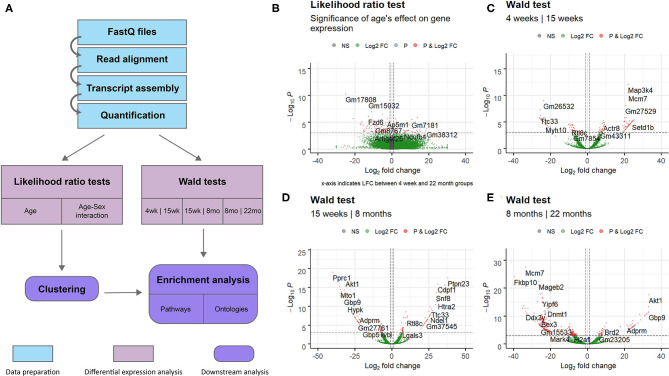
Overview of entire RNA-Seq data analysis workflow and volcano plots for dynamically expressed genes. Plots were constructed using the EnhancedVolcano (Blighe, 2019) package in R. Horizontal lines are drawn at p = 0.001. Vertical lines are added at log2 fold change values of 1 and −1. DESeq2's shrunken log2 fold change metric was used. Genes with significant differential expression (p < 0.001 and LFC >1 or LFC < −1) are colored red. (A) Flowchart of steps used to analyse RNA sequencing data obtained from mice of different age groups. Data preparation steps are colored in light blue, differential expression analysis steps are colored in pink, and downstream analysis steps are colored in purple. (B) Results of the likelihood ratio test using a reduced model with sex as the sole explanatory variable; genes identified as significant (red) vary in expression with age. (C) Results of the Wald test comparing gene expression in the 4 week group to expression in the 15 week group. (D) Results of the Wald test comparing gene expression in the 15 week group to expression in the 8 month group. (E) Results of the Wald test comparing gene expression in the 8 month group to expression in the 22 month group. This comparison identified the largest number of transcripts with p < 0.05 of the three pairwise comparisons.